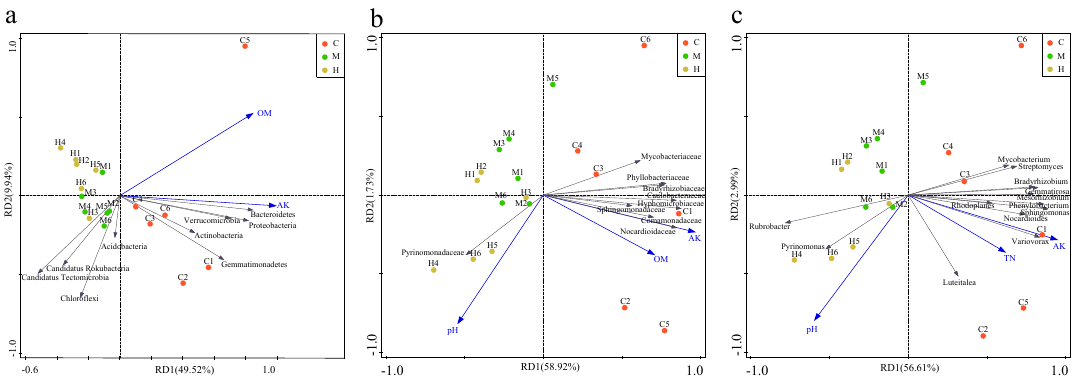
Figure 3. Redundancy analysis for the microbes among samples at ( a ) phylum, ( b ) family, and ( c ) genus levels with edaphic physicochemical factors,